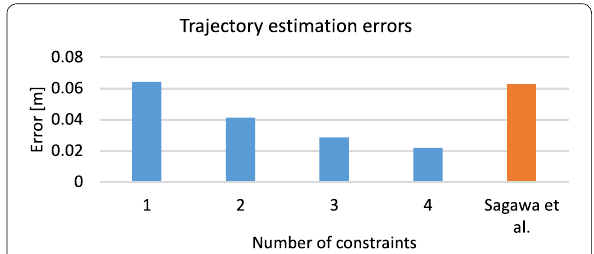
Fig. 8 Trajectory estimation errors with different number of con- straints (real IMU data)